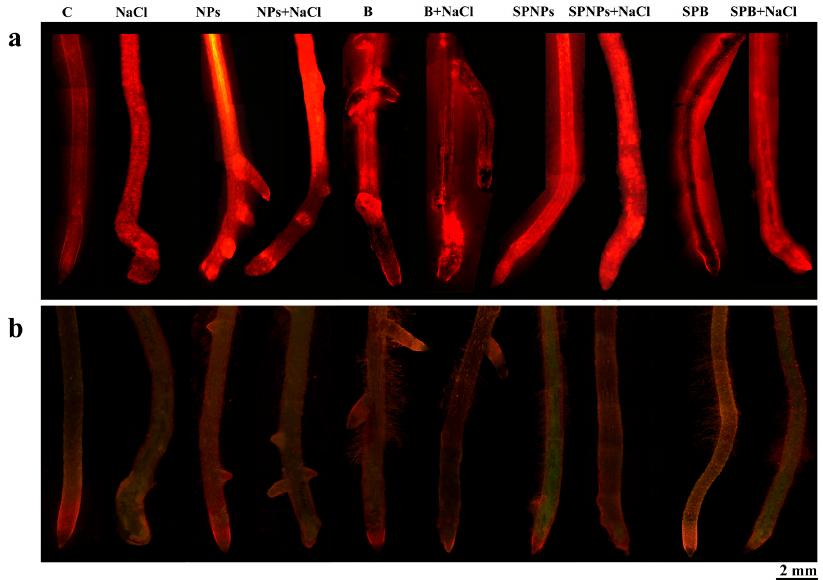
Figure 8. Histochemical analysis of root of comparable developmental level, randomly selected from plants without priming and salt treatment (C), with salt treatment without priming (NaCl), with ZnO treatment in the root zone (nanoparticles, NPs or bulk form, B), with ZnO priming in the root zone with salt treatment (NPs + NaCl or B + NaCl), with ZnO treatment as a leaf spray (SPNPs or SPB), and with ZnO priming as a leaf spray with salt treatment (SPNPs + NaCl or SPB + NaCl): the plate comprehends representative images of in situ detection of H 2 O 2 by the Amplex UltraRed Reagent ( a ) and in situ detection of TBARS by the BODIPY reagent ( b ).